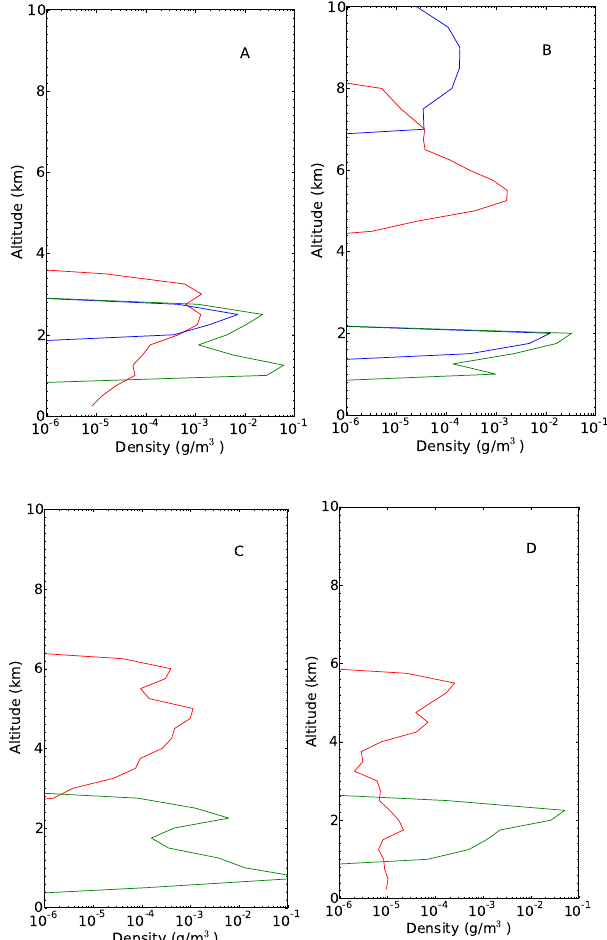
Fig. 8. The vertical ash (red), ice (blue) and water (green) cloud density profiles for the locations A (top left panel), B (top right), C (bottom left panel) and D (bottom right panel) in the top left panel of Fig. 5.